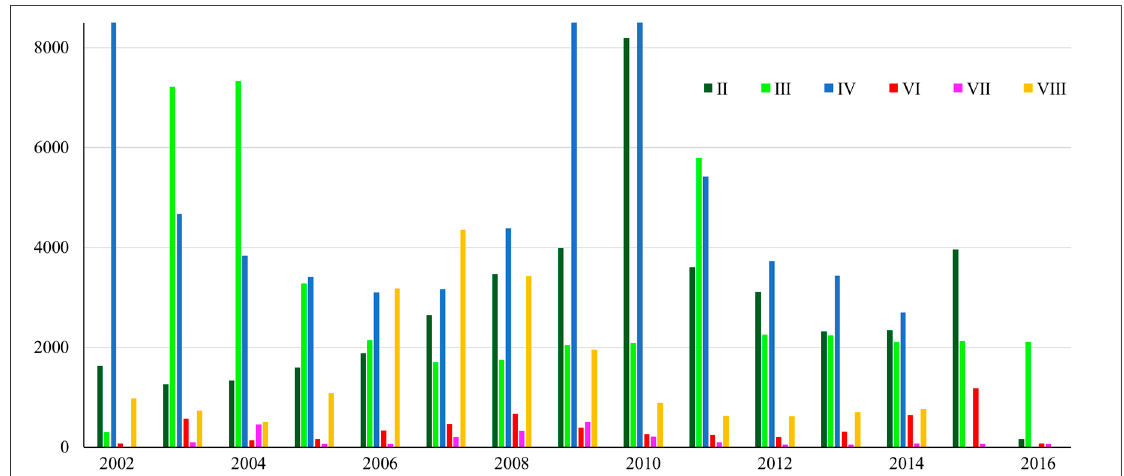
Figure 4. The transition years of the exponential pattern and the logarithmic pattern which have only one transition years during the observation period, and the first transition year of the logistic pattern.